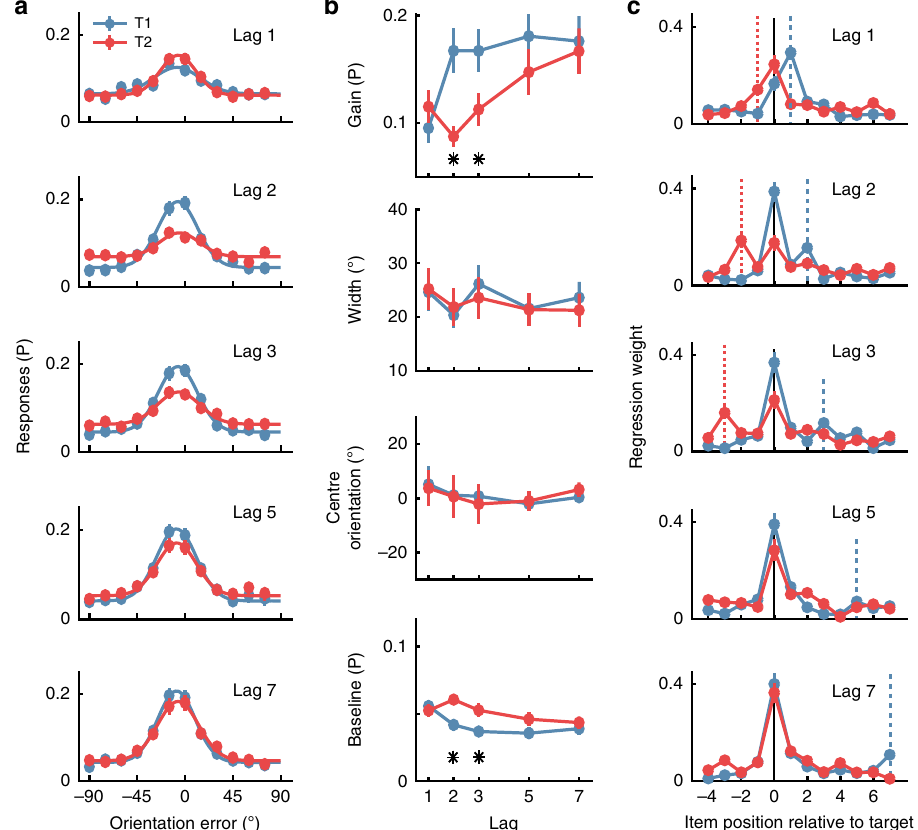
Fig. 2 Behavioural results for the RSVP task in Experiment 1. a The distribution of response errors (difference between presented and reported orientation) across participants ( N = 22) for the fi rst (T1, blue lines) and second (T2, red lines) target for each Lag condition. The line shows fi tted four- parameter Gaussian function. b Quanti fi ed behavioural responses for the four parameters of the fi tted Gaussian function (see Supplementary Fig. 1) for each participant. Gain shows the amplitude, width shows the standard deviation of the function, centre orientation is the mean (which should be centred around 0° for unbiased estimates), and baseline is a constant parameter accounting for non-orientation selective responses which indicates guessing. Asterisks indicate Bonferroni-corrected t -tests showing signi fi cant differences at p < 0.05. c Regression results for the in fl uence of distractors and targets on participants ’ responses. Higher regression weights indicate that a given item ’ s orientation was more in fl uential for determining the reported orientation. The dotted vertical lines indicate the position of the other target (colour matched). Consider, for example, the panel depicting Lag 2 results. For T1 report, T2 occurred at item plus 2 as indicated by the dotted blue line, whereas for T2 report, T1 occurred at item minus 2, as indicated by the dotted red line. Across all panels, error bars indicate ∓ 1 standard error of